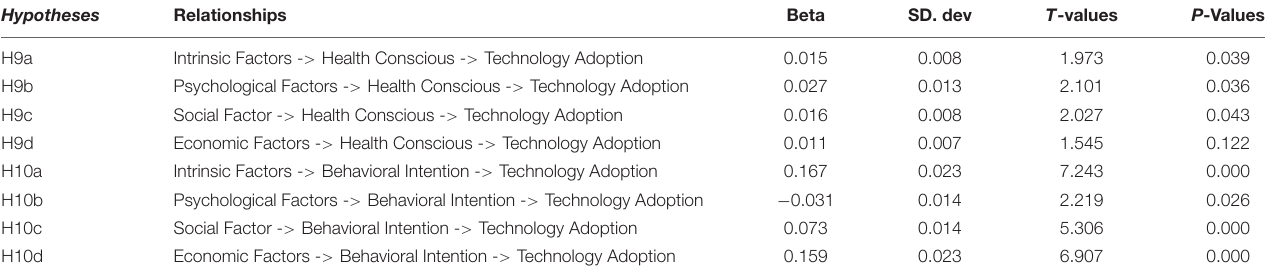
TABLE 7 | Meditation results.